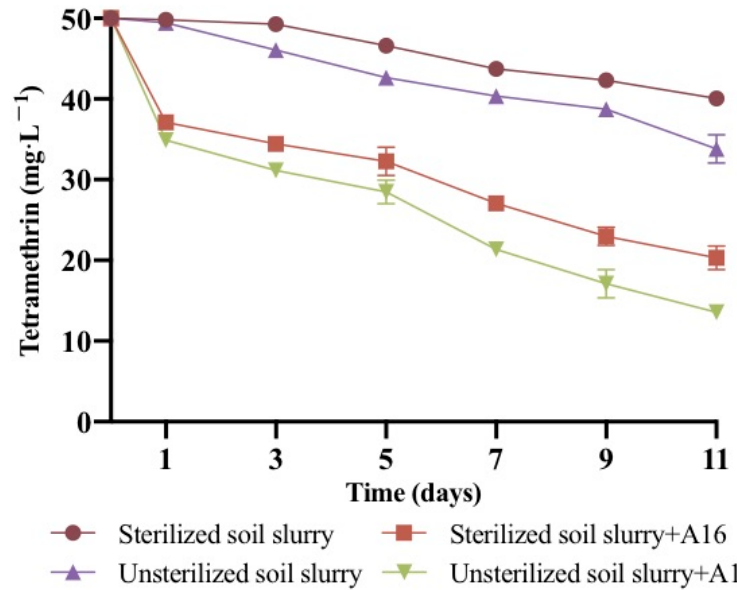
Figure 7. Degradation kinetics of tetramethrin in different soil slurries.